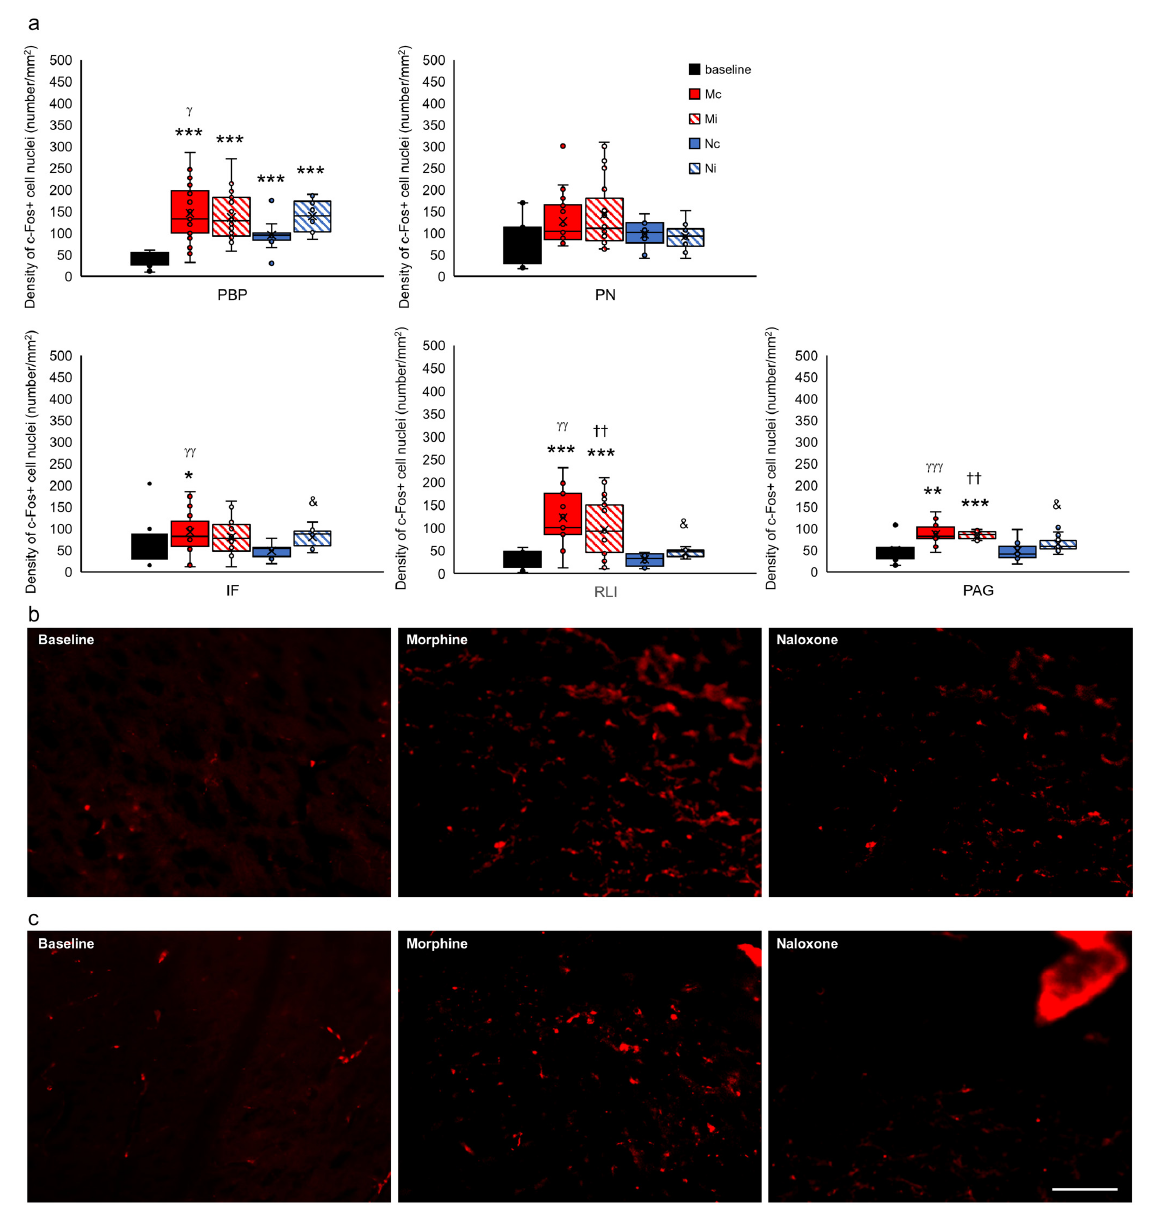
vs. Nc group); †† p < 0.01, ††† p < 0.001 indicate a significant difference in the ipsilateral side groups between different injection drug: morphine or naloxone (Mi vs. Ni group).